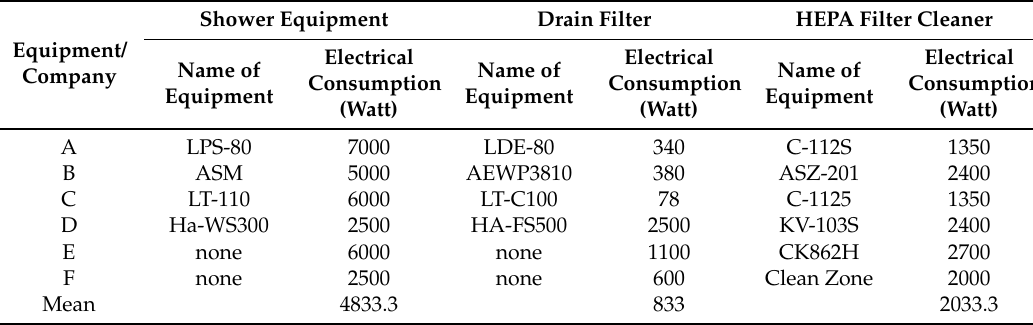
Table 3. Model number and electric power consumption of input-equipment.